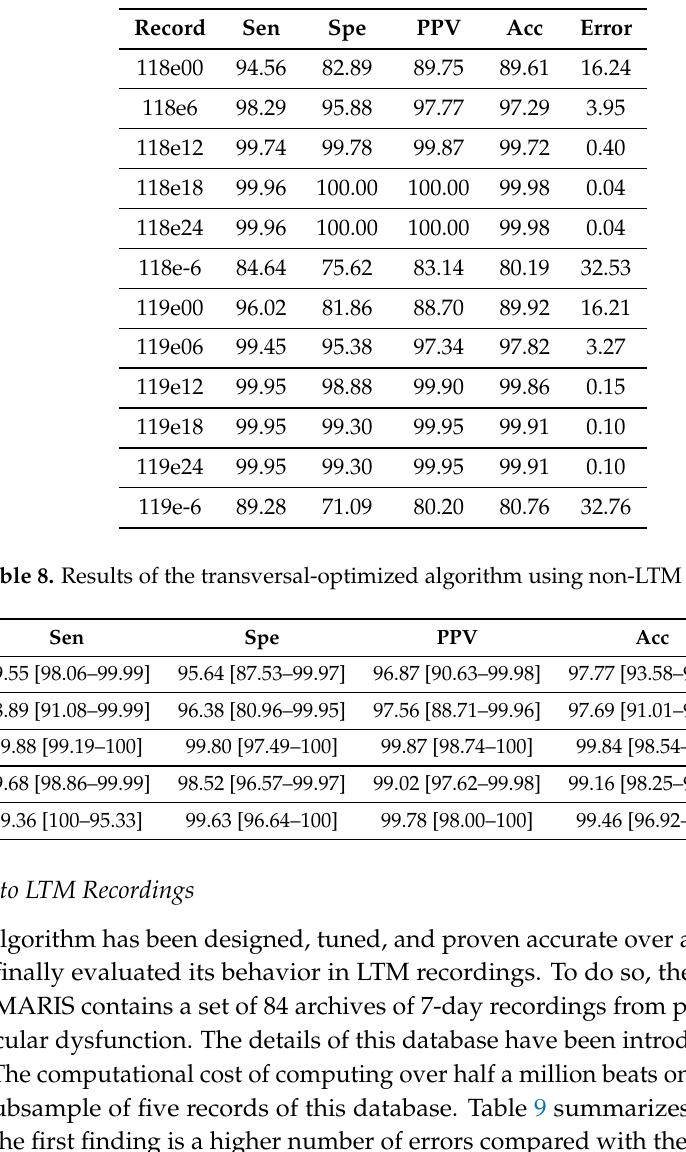
Table 7. Results of the transversal-optimized algorithm using the NSTDB.